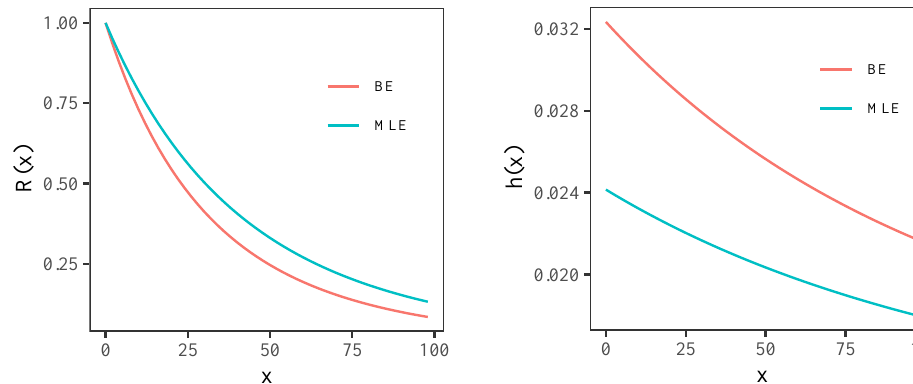
Figure 7. Point estimates of R ( x ) ( left ) and h ( x ) ( right ) for the real dataset.